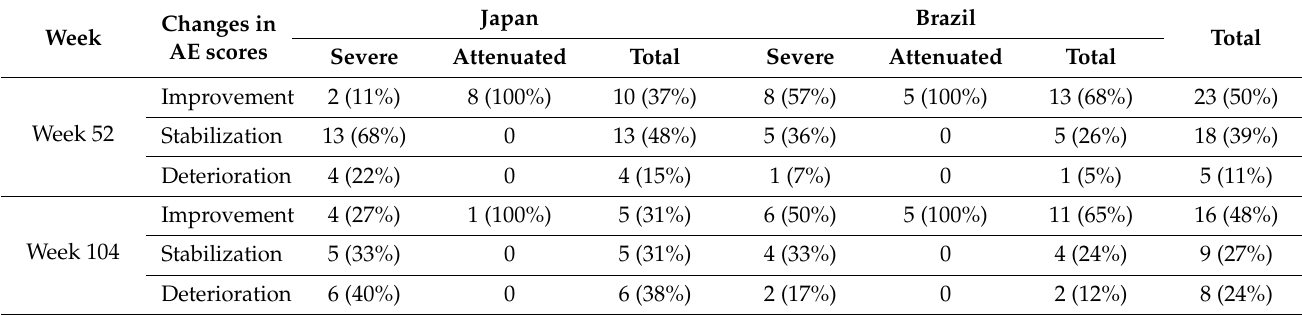
Table 1. Changes in AE scores on KSPD (for Japan), BSID-III, and KABCII (for Brazil). Changes in AE scores exceeding 3 months were defined as improvement, while those ± 3 months were defined as stabilization and those below 3 months were defined as deterioration (updated from [14] and [15]).